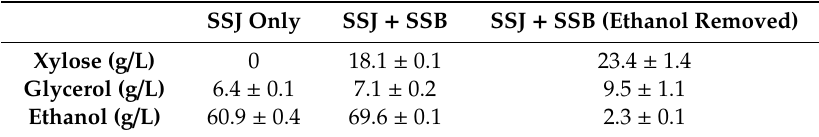
Table 2. Ethanol fermentation results for sweet sorghum juice (SSJ) and SSJ combined with LMAA-treated